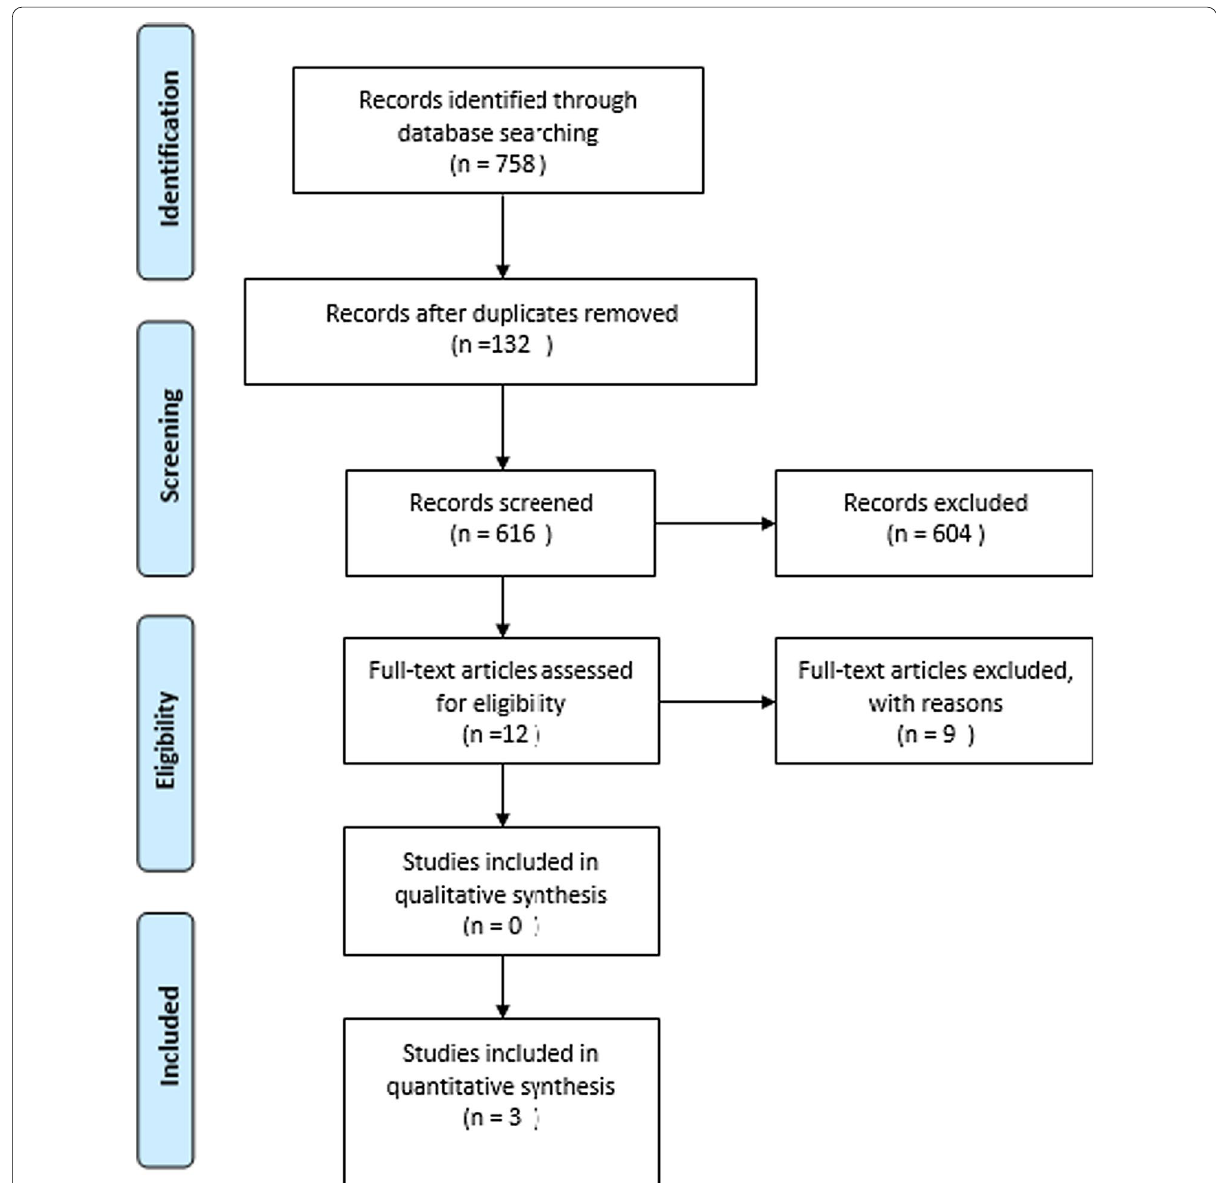
Fig. 1 PRISMA Flow diagram of literature searched and selection